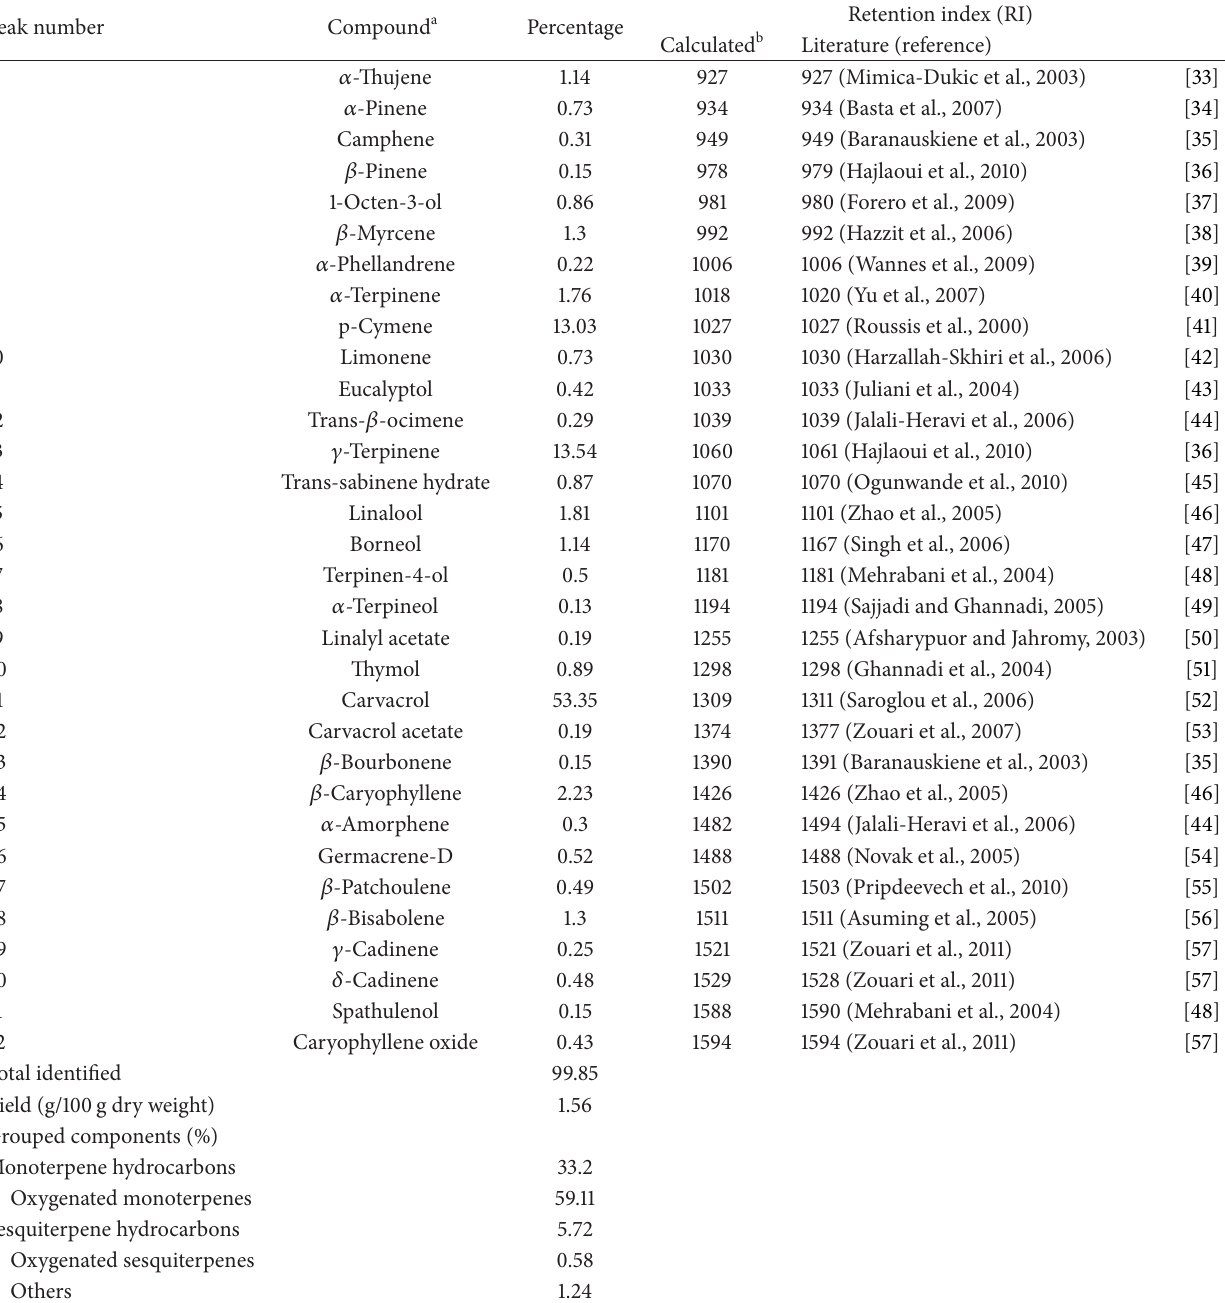
Table 1: Mean percentage of the Satureja montana L. (France) essential oil components and RI comparison according to the literature. Peak